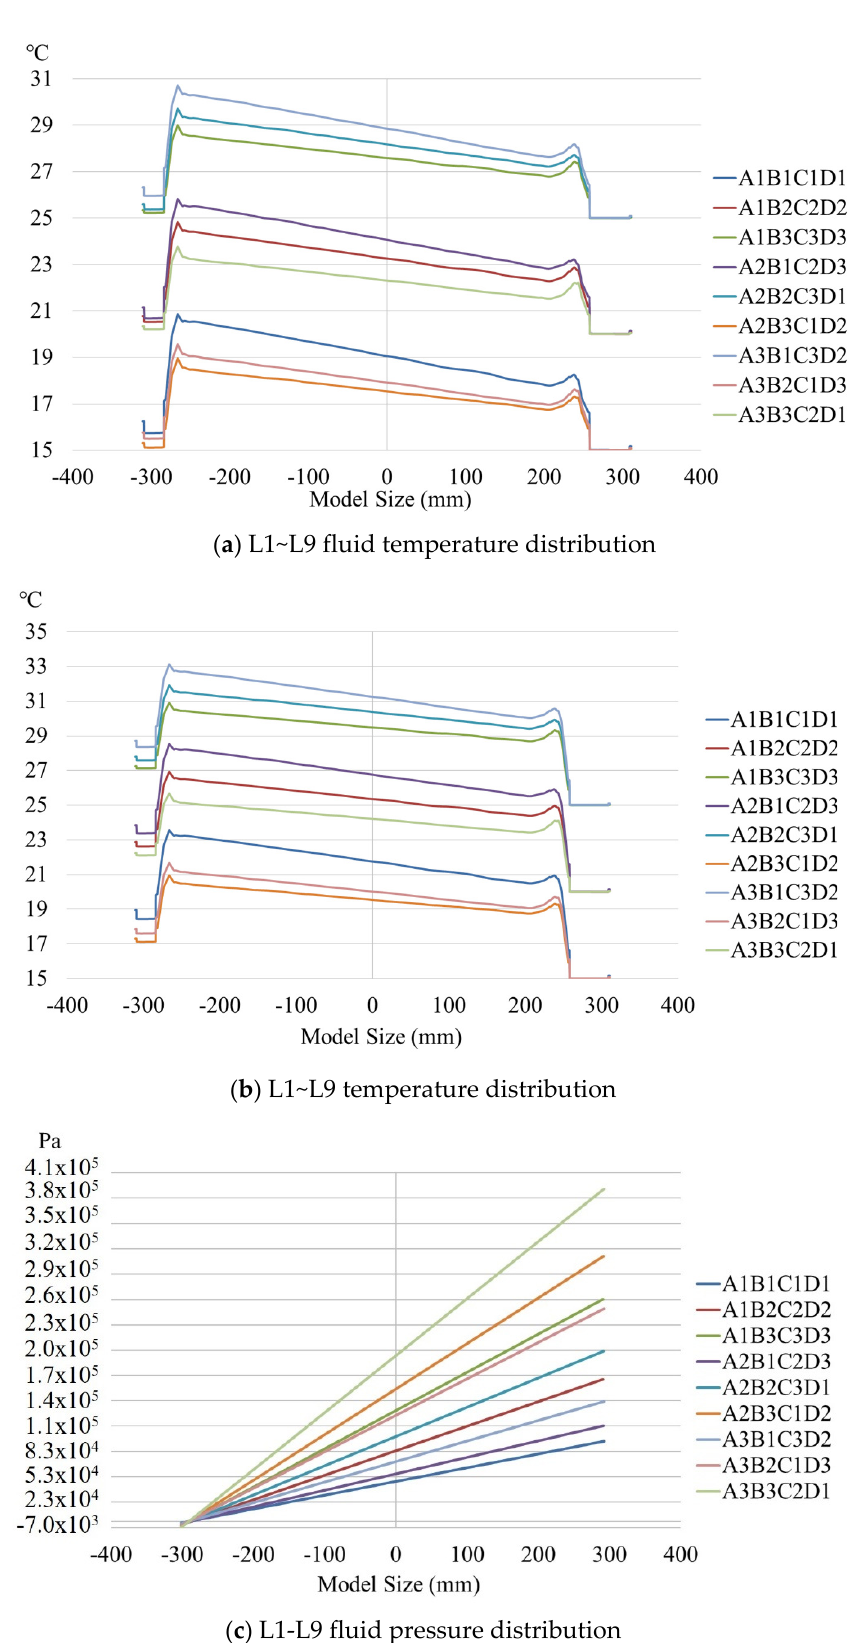
Figure 9. Analysis diagram of the simulation results of the L1-L9 cold plates.